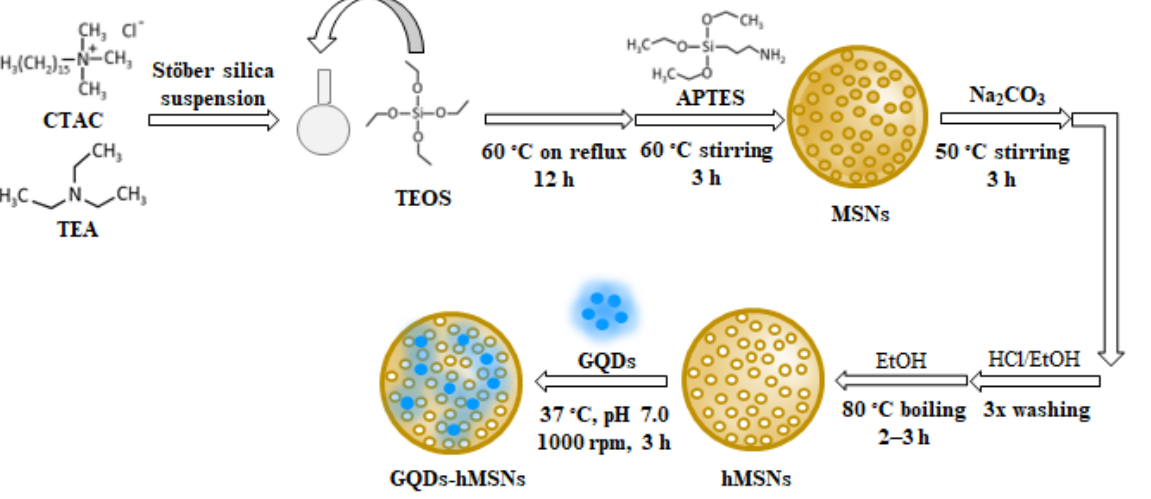
Scheme 1. Synthesis of GQDs-hMSNs using Stöber silica suspension and previously synthesized